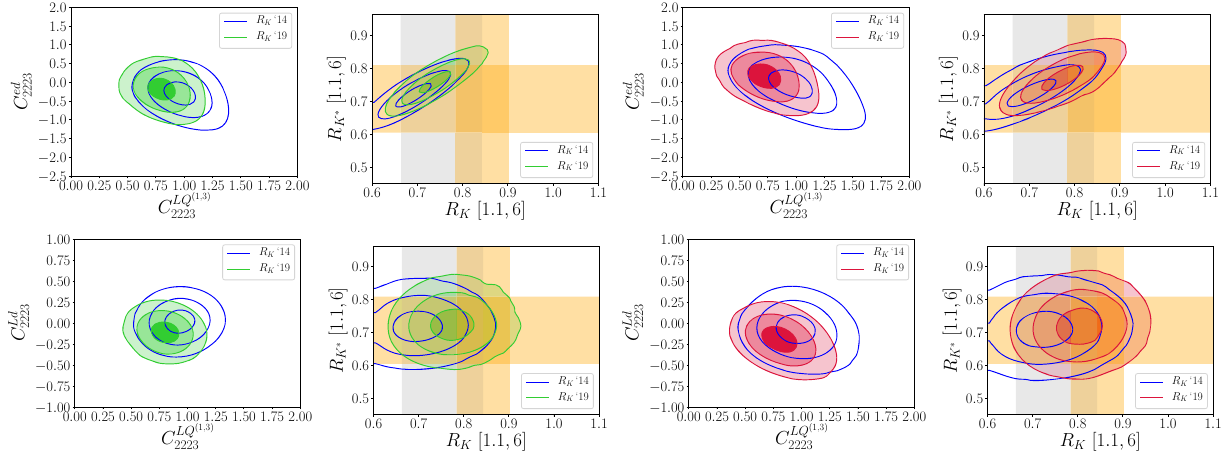
, C ed ) defined belowFig.2. Second row: analogous tothe first row, but relative 2223 2223 , C Ld to the WCs ( C LQ 2223 2223